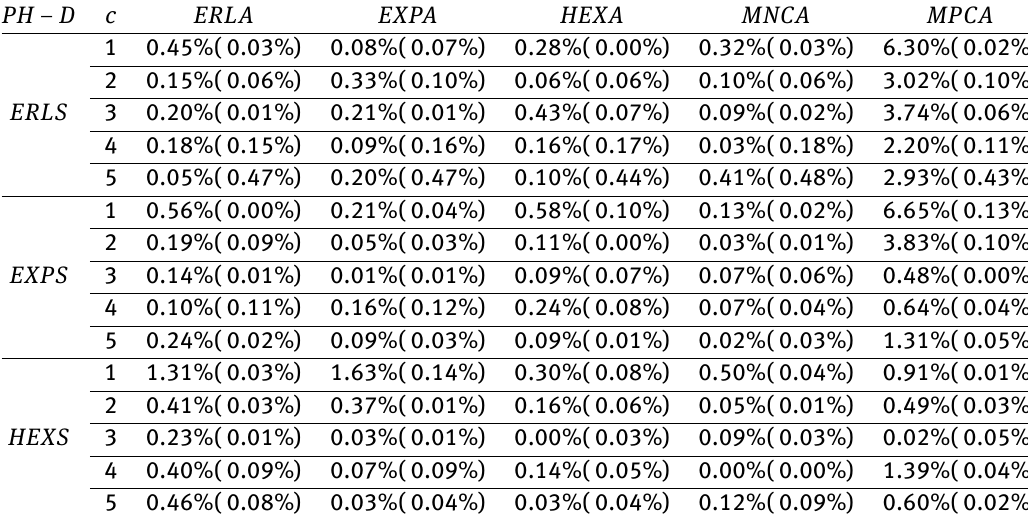
Table 1: Error percentages for E ( L )( E ( C )) under various scenarios for FJ system